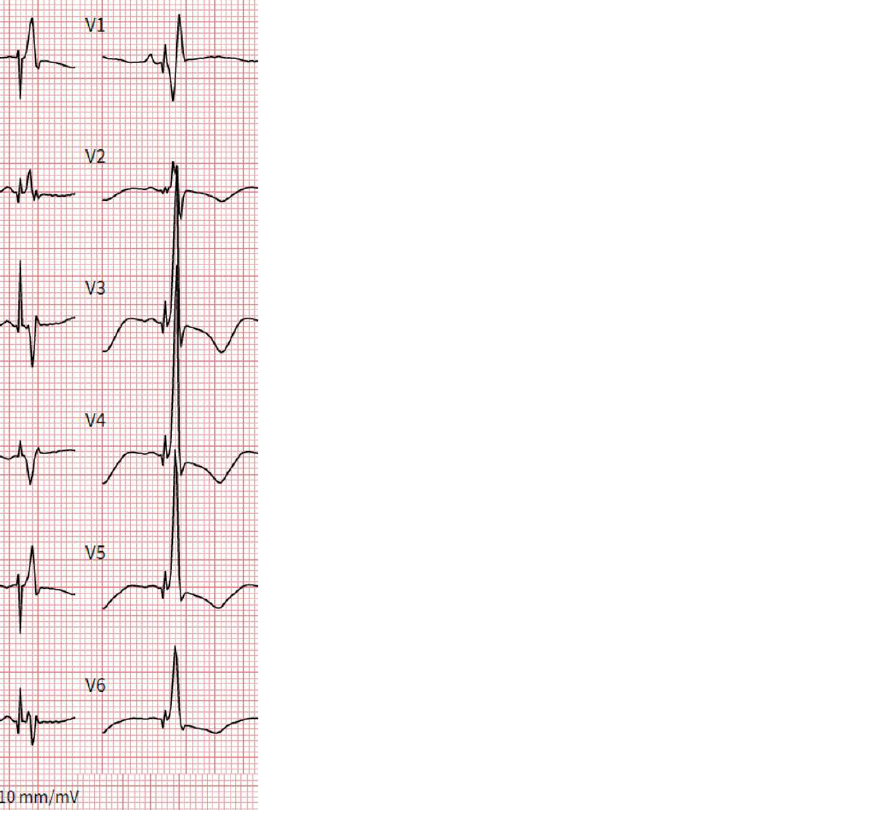
Figure 1. Paced QRS morphology in a patient with a dual-chamber PM and an LBBAP lead. V1 exhibits an R’, R-wave peak time in V6 is ~70 ms, the V1–V6 interpeak interval is ~35 ms and paced QRS duration is ~120 ms.